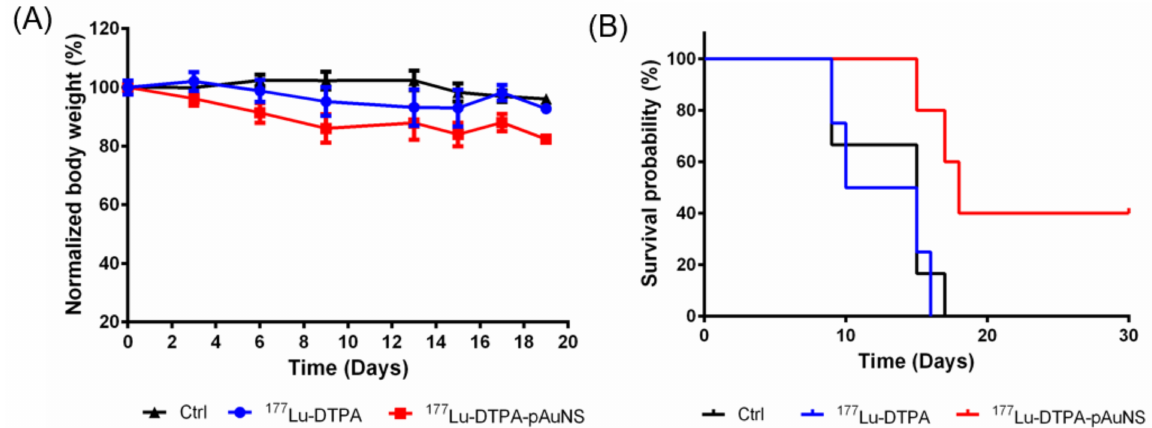
Figure 5. ( A ) The body weight of the mice in each group during the treatment course. The mice in the control group, 177 Lu-DTPA-injected group, and 177 Lu-DTPA-pAuNSs-injected group were treated with normal saline, 200 µ Ci of 177 Lu- DTPA, and 200 µ Ci of 177 Lu-DTPA-pAuNSs, respectively (n = 5). ( B ) The percentage of survival for each group at indicated time